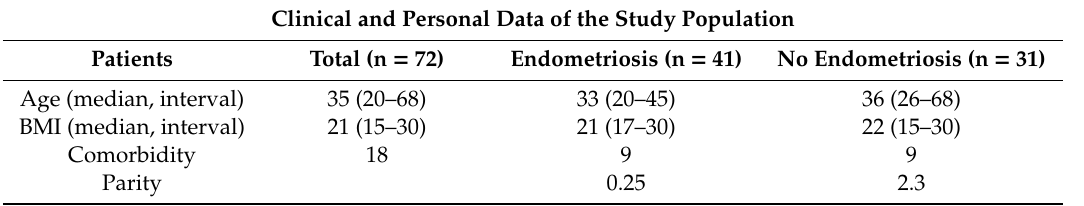
Table 1. Clinical and personal data of the study population. BMI, body mass